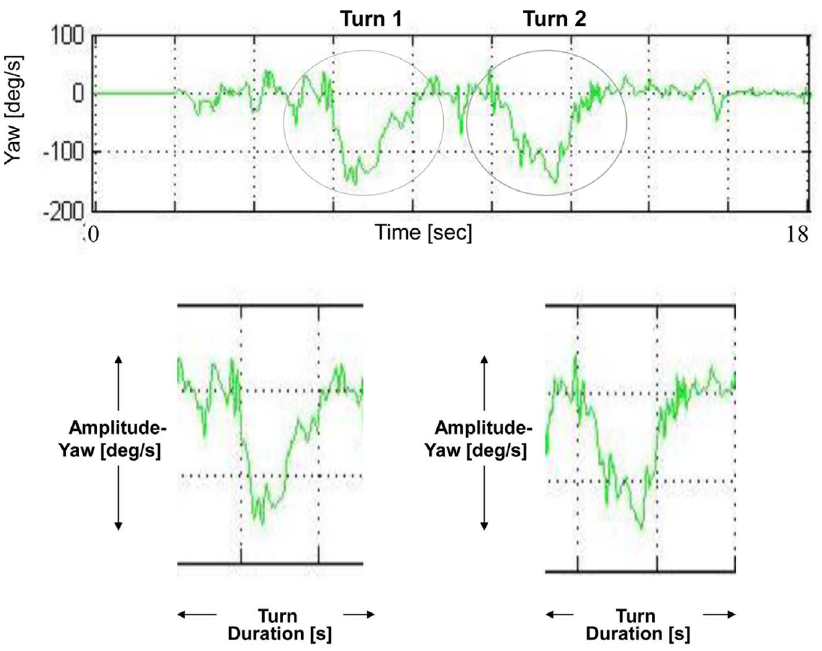
Figure 4. Turn component. Turn component derived from the yaw axis. The upper figure shows the TUG yaw signal, where turn 1 and turn 2 components are evident as ‘‘concave’’ shaped objects. The lower figure shows a close-up of both yaw turns, depicting the turn yaw amplitude [deg/s] and the turn duration [s] measures (number of steps during the turns is not showed here, as it is derived from the vertical axis).